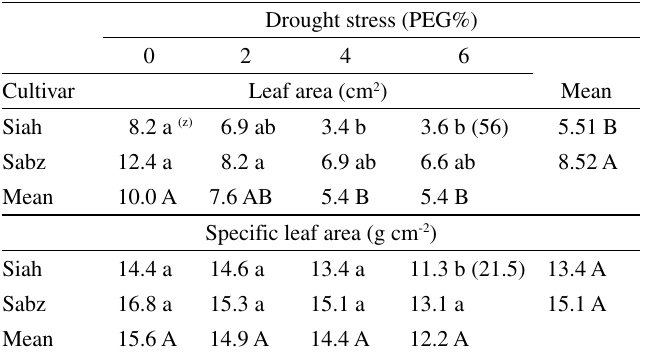
Table 2 - Interaction of water stress and cultivar on leaf area (cm 2 ) and specific leaf area (g cm -2 ) of micro shoots Drought stress